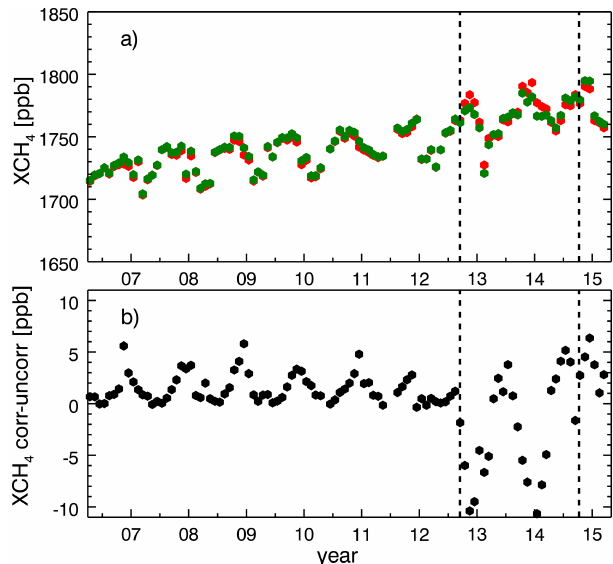
Figure 8. (a) Comparison of a posteriori-corrected (green) and uncorrected (red) Zugspitze XCH 4 monthly mean time series. (b) Time series of differences between a posteriori-corrected and uncorrected XCH 4 monthly mean time series.